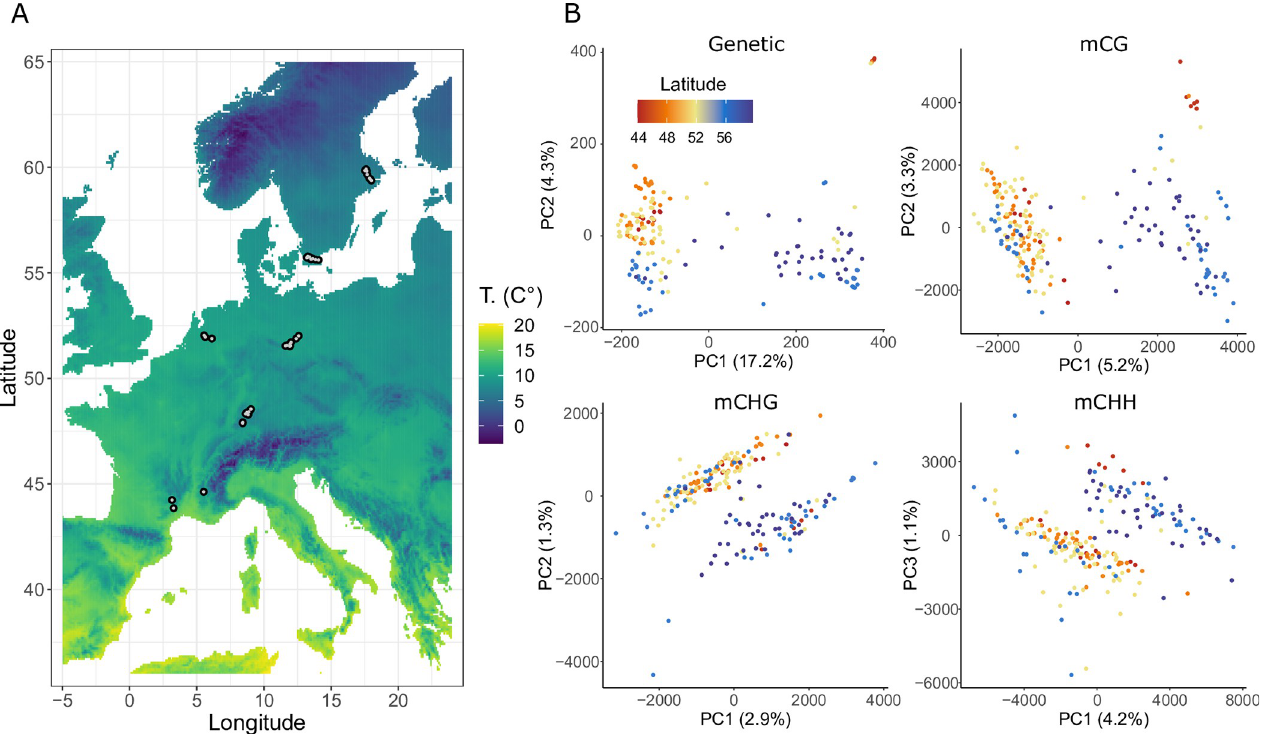
Fig 1. Geographic distribution and population structure of the 207 sampled Thlaspi arvense lines. (A) Geographic locations of the 36 populations. The background colours are gridded satellite data of average daily temperature (T.) from the Copernicus programme [44]. (B) PCA plots of all 207 lines based on DNA sequence (“Genetic”) and DNA methylation in different sequence contexts (“mCG”, “mCHG” and “mCHH”).